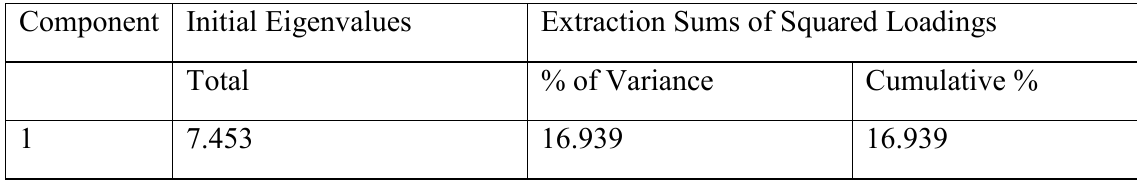
Table 1.1: Variance explained for Absorptive Resilience PC1